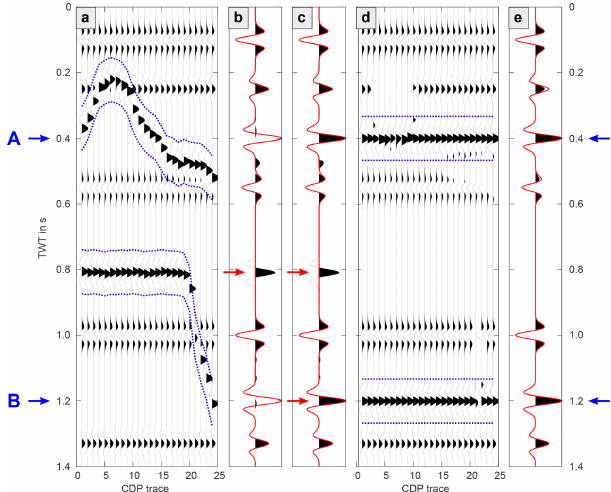
Figure 4. Synthetic CDP gather illustrating the principle of the cross-dip correction. Panel (a) shows a NMO-corrected CDP gather including two reflections with 10 ◦ cross-dip originating at 0.4s (A) and 1.2s (B). The cross-offset distribution corresponds to the cross- offset distribution of CDPs 350 and 1350 of the Burträsk data and the dotted blue lines mark a window around the biased reflection time, t 0 + (cid:49)t cross . The comparison of the uncorrected stack (wiggle trace) with the theoretical stack (red line) in panel (b) indicates that reflection A is missing and reflection B is shifted. In the slant stack in panel (c) , reflection A is correctly imaged but reflection B ap- pears twice in the trace. The CDP gather after cross-dip correction in panel (d) shows that reflections A and B are shifted back to their origin time, t 0 . In the stack of the corrected CDP gather in panel (e) , both reflections are correctly